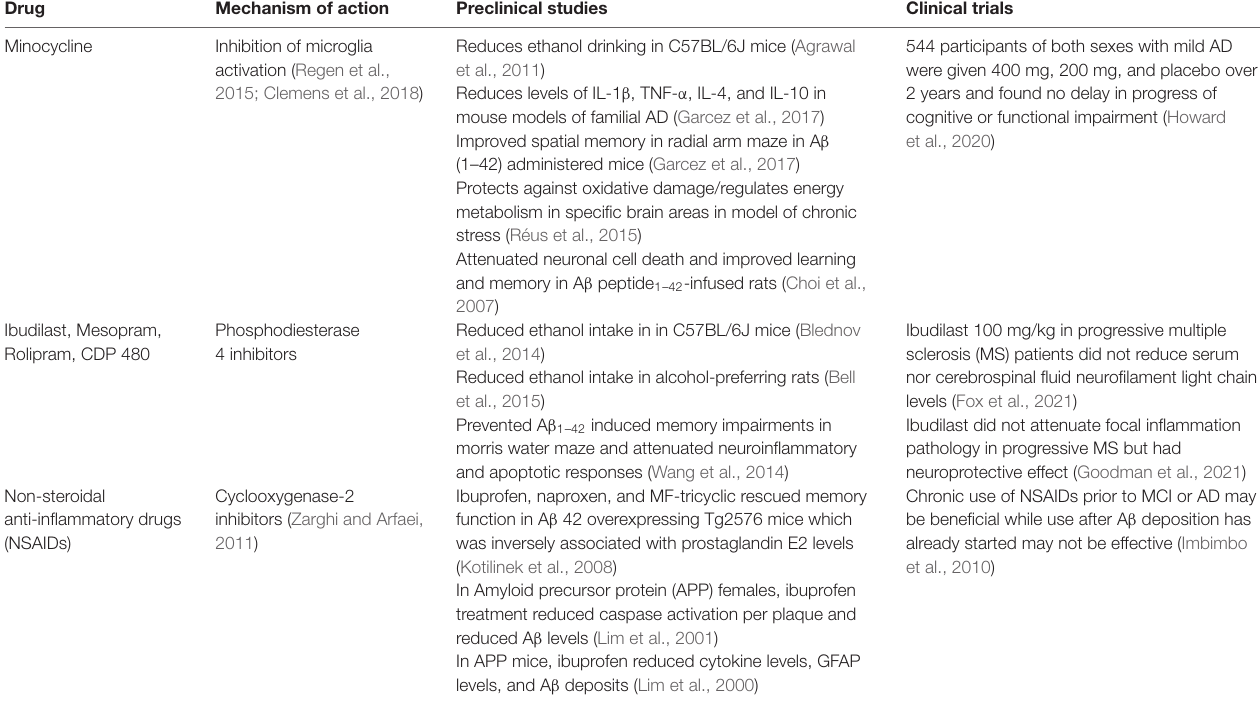
TABLE 1 | Potential anti-inflammatory medications for alcohol use disorder and Alzheimer’s disease. Drug Mechanism of